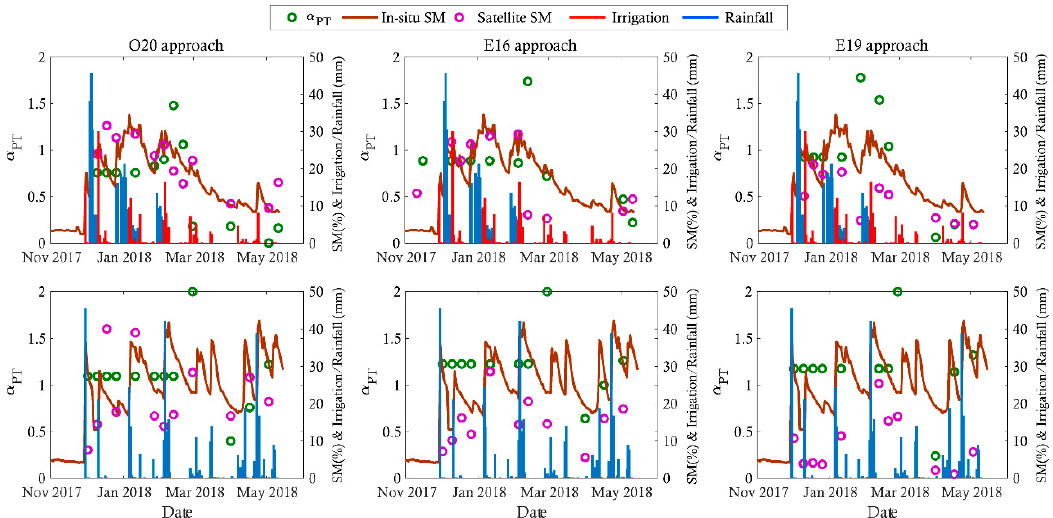
Figure 5. Daily retrieved α PT (green points) superimposed with SM-5 cm, irrigation, and rainfall events for the three SM retrieval approaches (red points) and in-situ SM at the Chichaoua and Sidi Rahal sites.